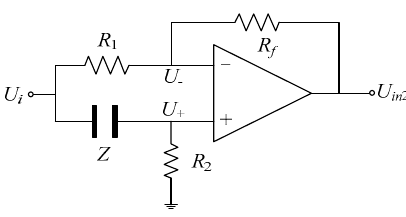
Figure 7. Schematic diagram of basic phase shift circuit.